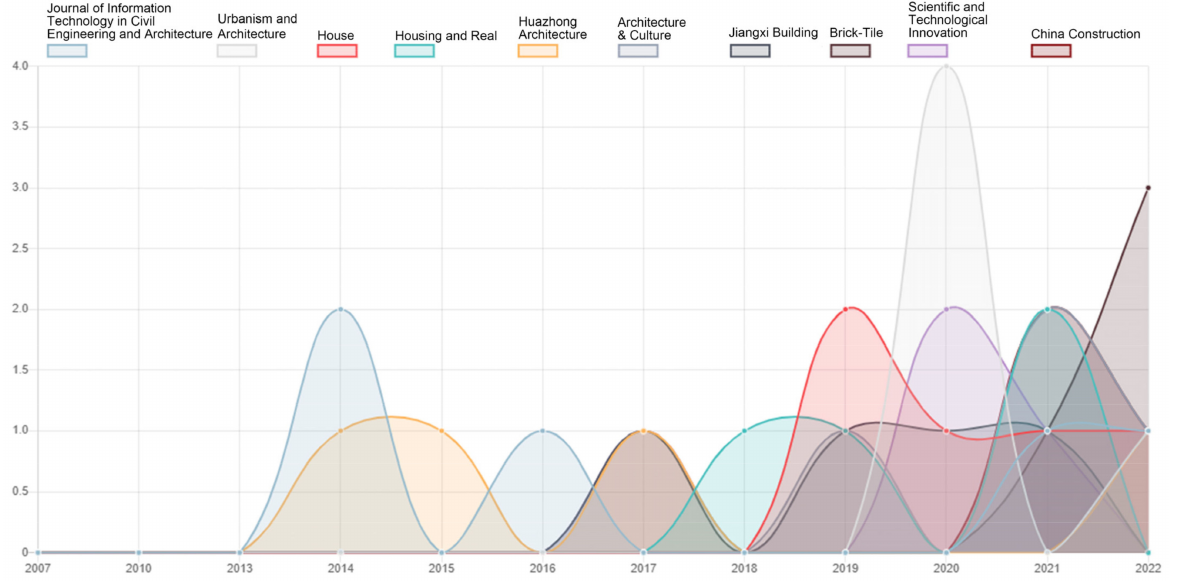
Figure 6. Trend of the number of papers on “BIM” and “architectural heritage” published in various journals from 2007 to 2022 (167